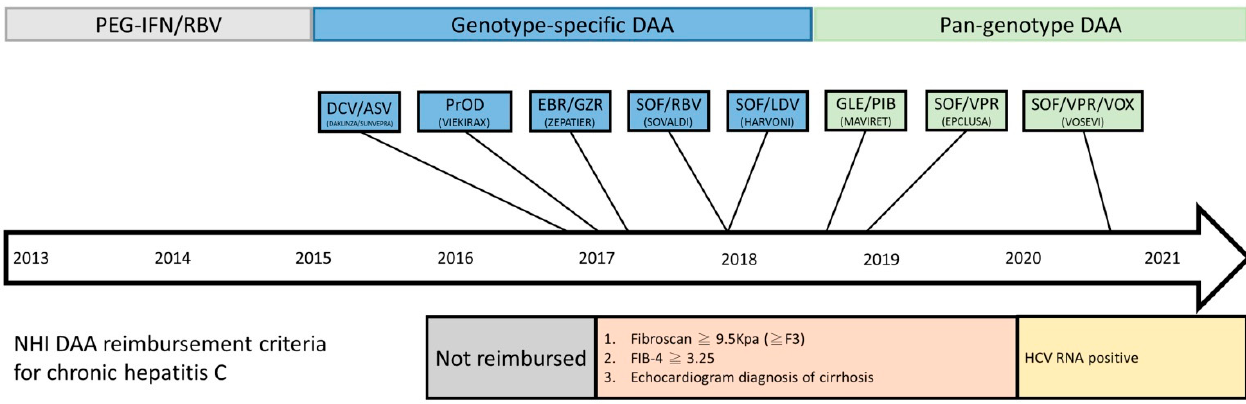
Figure 1. Timeline of DAA reimbursement in National Health Insurance (NHI) in